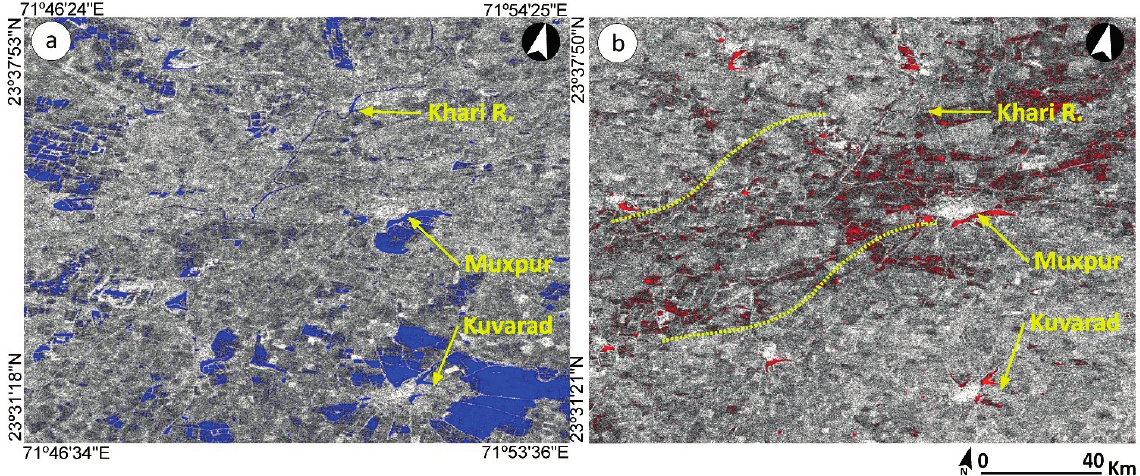
Figure 7. Khari River (KR) subset of interest showing the flooding maps for ( a ) MA monsoonal (blue pixels) and ( b ) MA post-monsoonal images (red pixels). Note the post-monsoonal low amplitude (dark pixels) in the field banks located within the Khari River basin area (yellow dotted